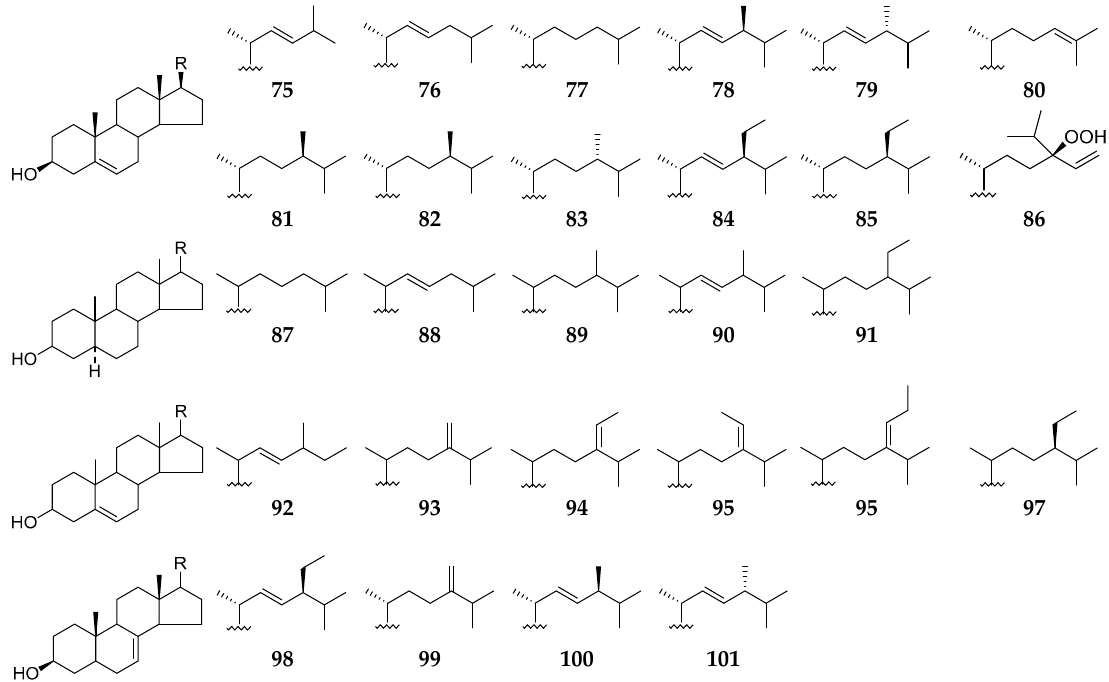
Figure 9. Sterols 75 – 101 from the subgenus Reniera.